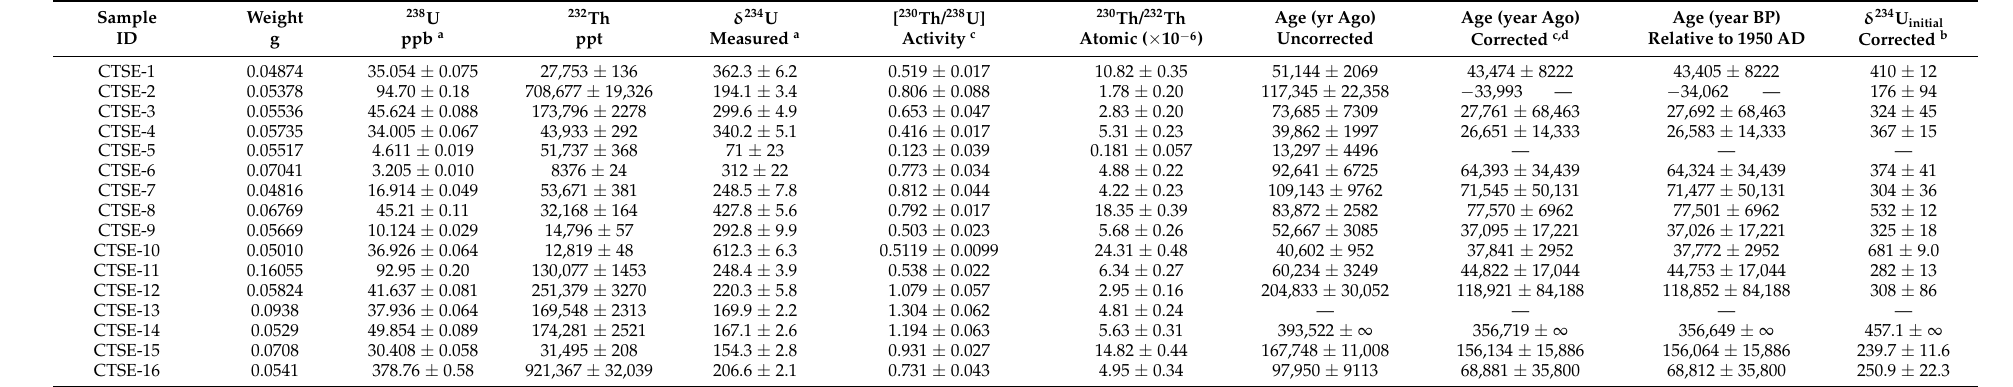
Table 1. U–Th isotopic compositions and contents and ages by MC-ICPMS. For location of samples CTSE1–16, see Figure 6. a: [ 238 U] = [ 235 U] × 137.818 ( ± 0.65‰) [67]; d 234 U = ([ 234 U/ 238